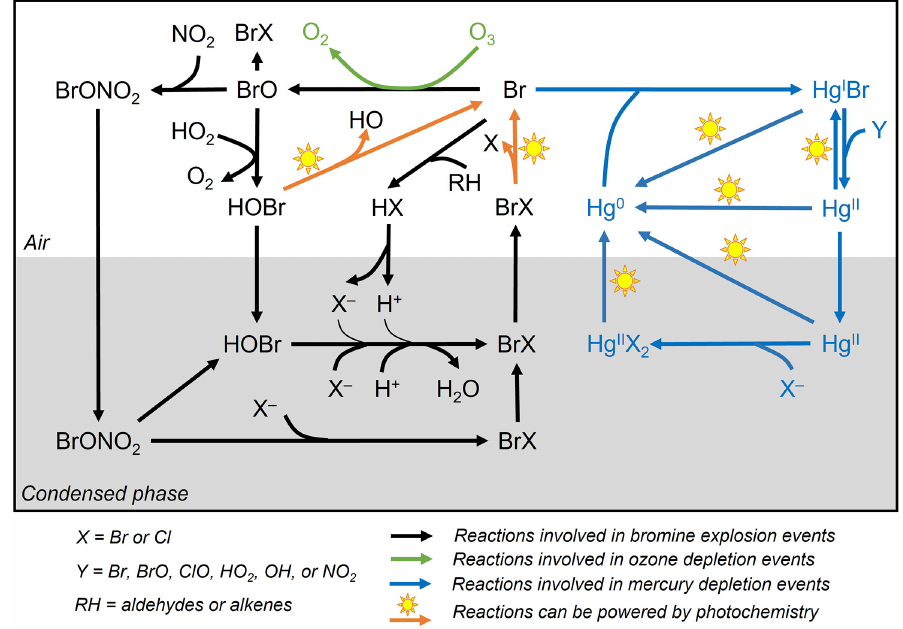
Figure 1. General reaction schemes involved in bromine explosion events, ozone depletion events, and mercury depletion events in the Arctic during polar sunrise. The photochemical activation of gas-phase reactive bromine species (Br and BrO) produced from multi-phase reactions on the surface of the condensed phase causes the depletion of ozone and gaseous elemental mercury in the boundary layer air (based on Abbatt et al., 2012; Aguzzi and Rossi, 2002; Khiri et al., 2020; Saiz-Lopez et al., 2018, 2019; Saiz-Lopez and von Glasow, 2012; Simpson et al., 2007b, 2015; Wang et al., 2017, 2019; Wang and Pratt,